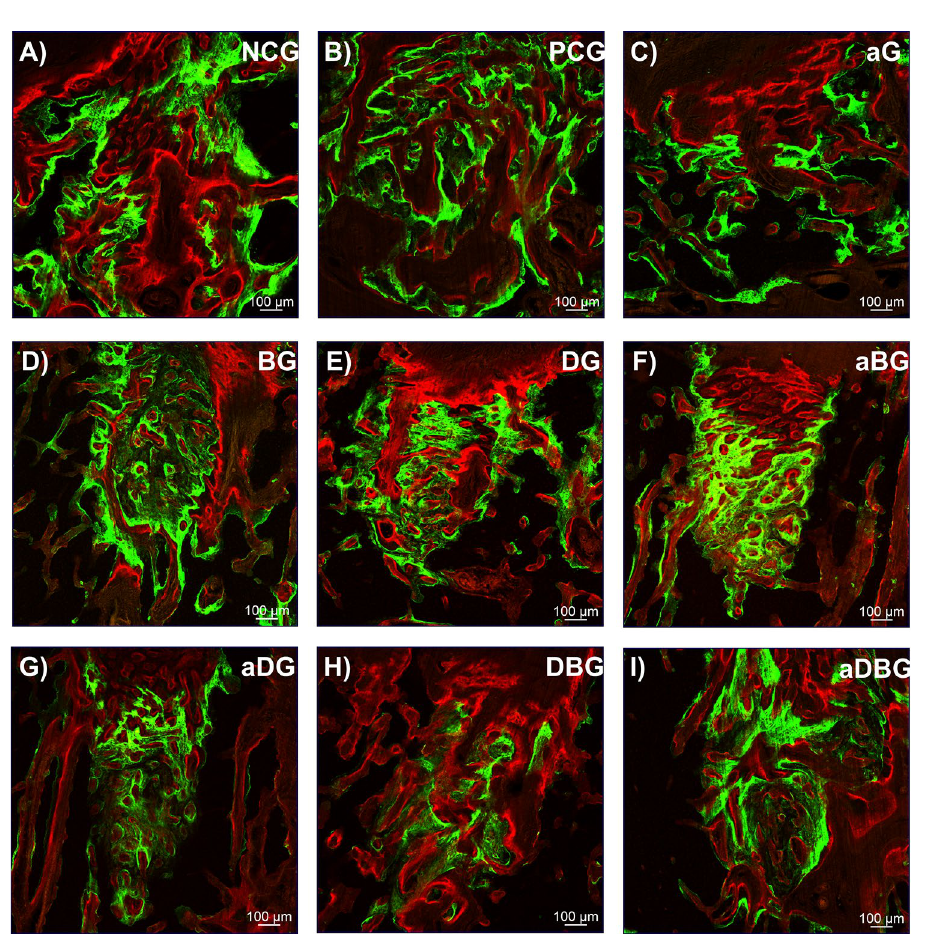
Figure 5. Images representing the dynamics of mineral apposition in the tissue as observed through a confocal laser microscope (10 ×) with calcein fluorochrome (stained in green) and alizarin fluorochrome (stained in